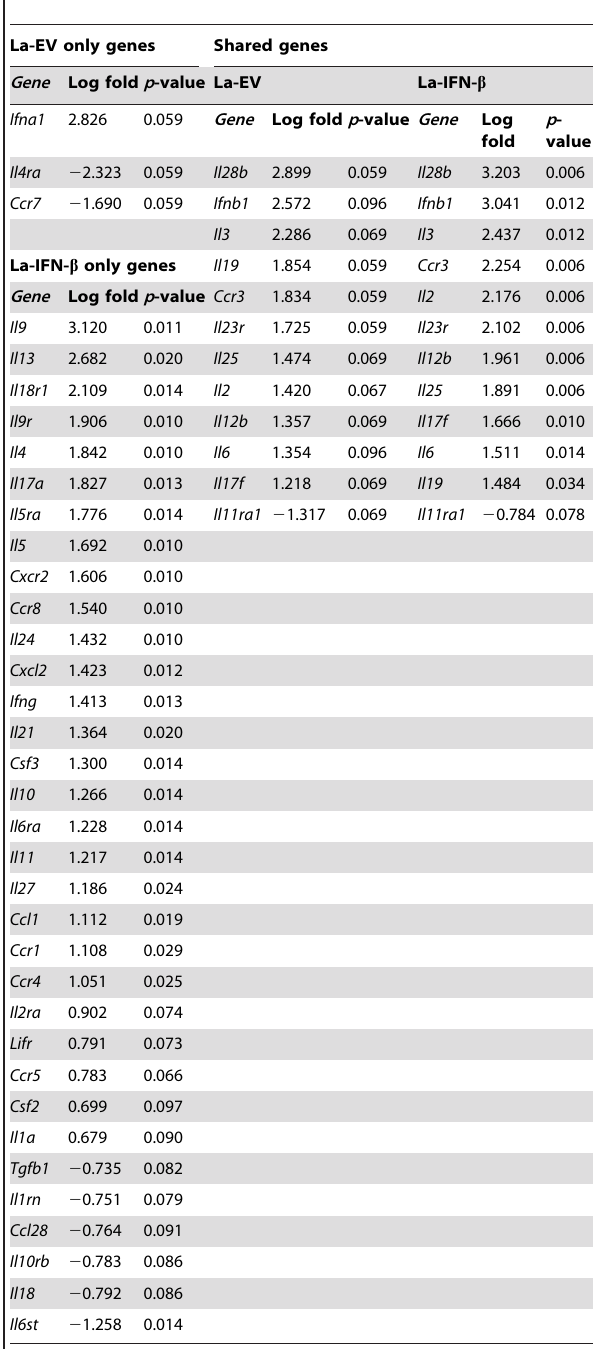
Shown are the fold changes in genes which were significantly* (p , 0.10) dysregulated in colitic mice (n=3/group) pretreated with La-EV or La-IFN- b compared to the PBS control.